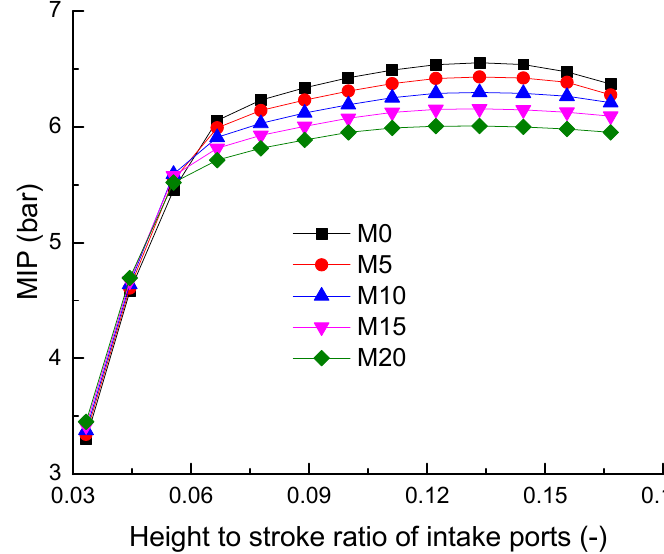
Figure 2. MIP for different height to stroke ratios of intake ports.